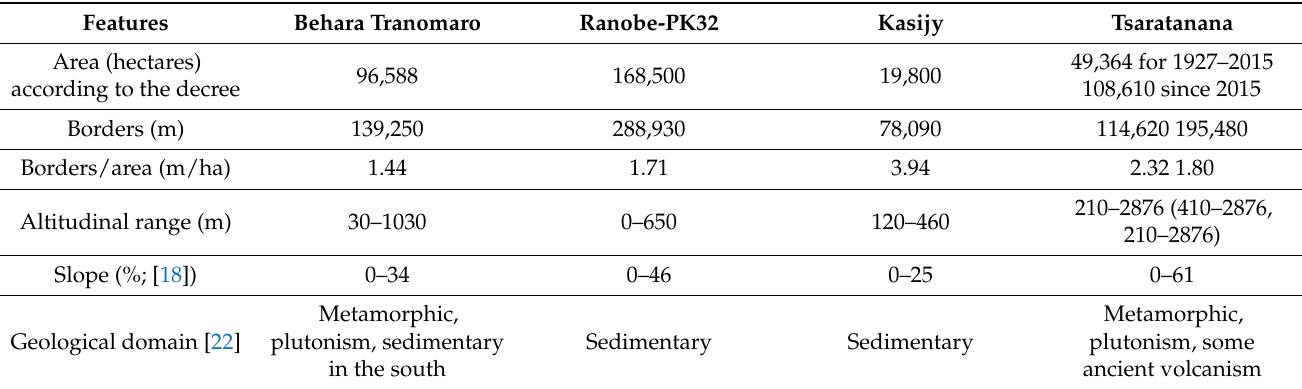
Table 1. Main features contextualizing the four protected